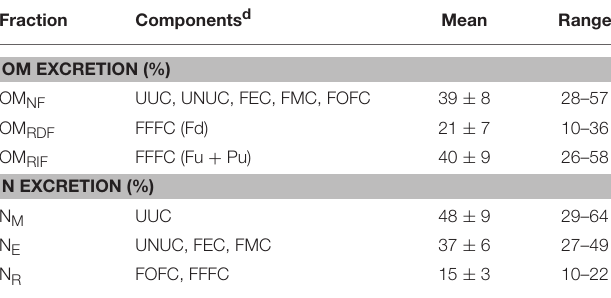
TABLE 6 | Proportional composition (%) of organic matter (OM) a and nitrogen (N) b in dairy cow excreta after simulation of 40 nutritional strategies c